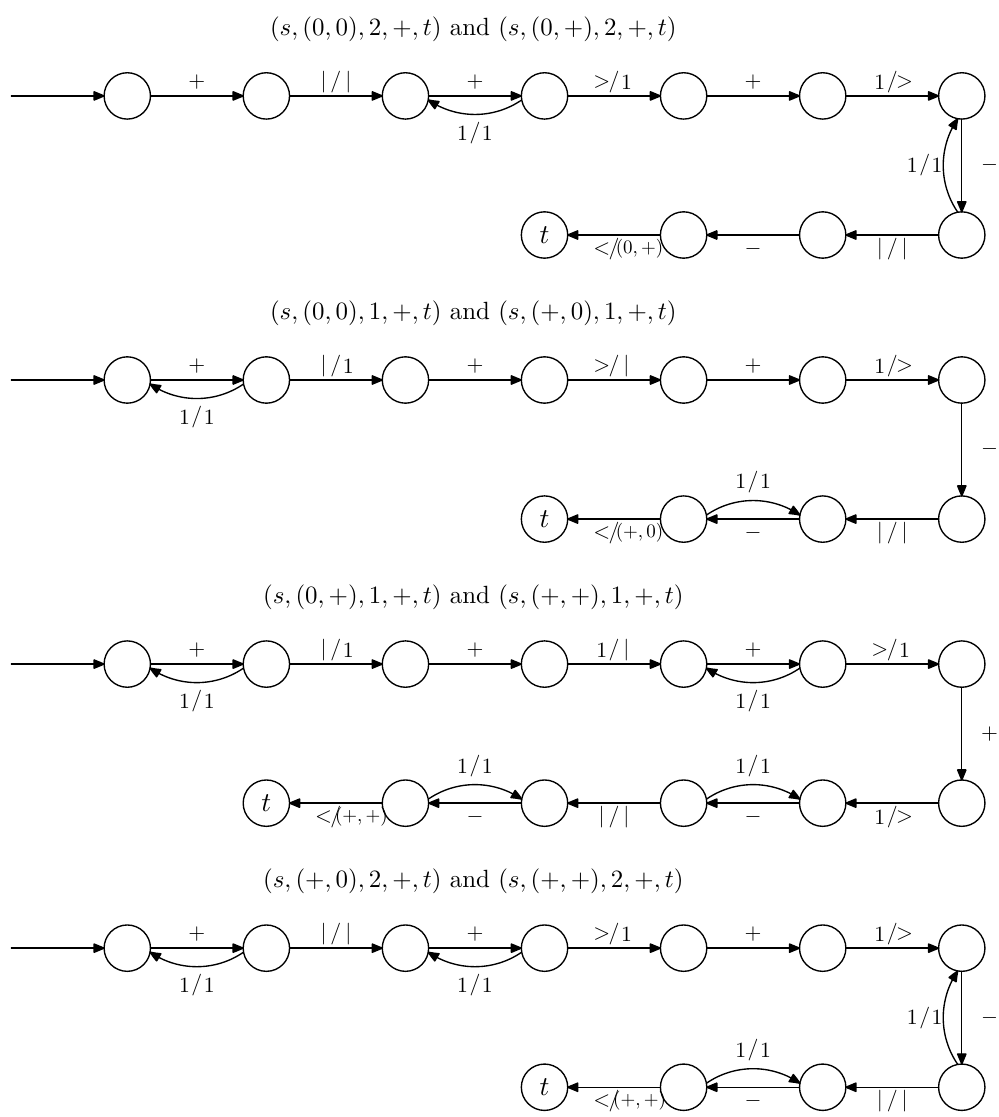
Tab. 1: Sub-routines corresponding to the different adding